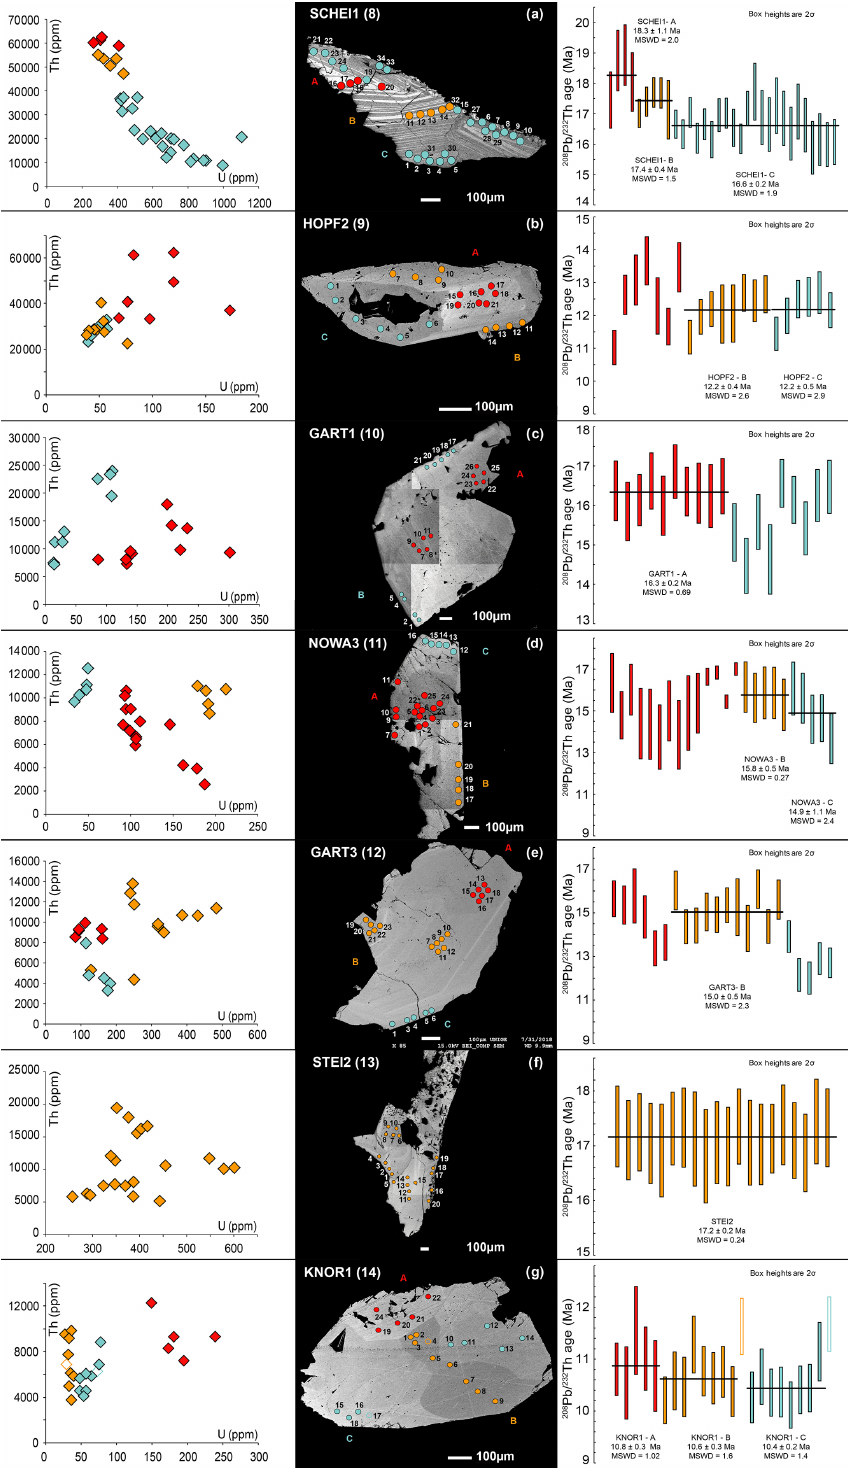
Figure 4. Chemical, textural and geochronological information of monazite grains from the central TW. On BSE images, colour-filled circles correspond to ion probe spot locations. Note that the square-shape shading in grains 10 and 11 is due to an artefact of composing BSE images with diverse